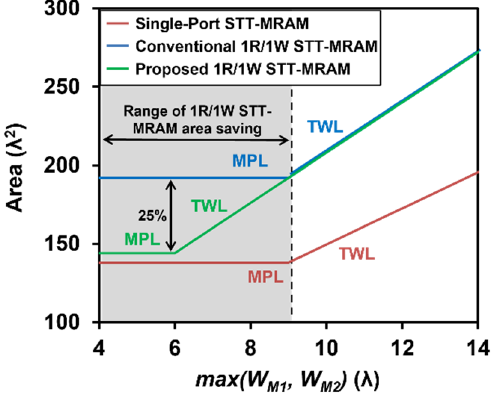
Figure 10. Bit-cell area comparison between single-port STT-MRAM, 1R/1W STT-MRAM, and the proposed MRAM. proposed MRAM.